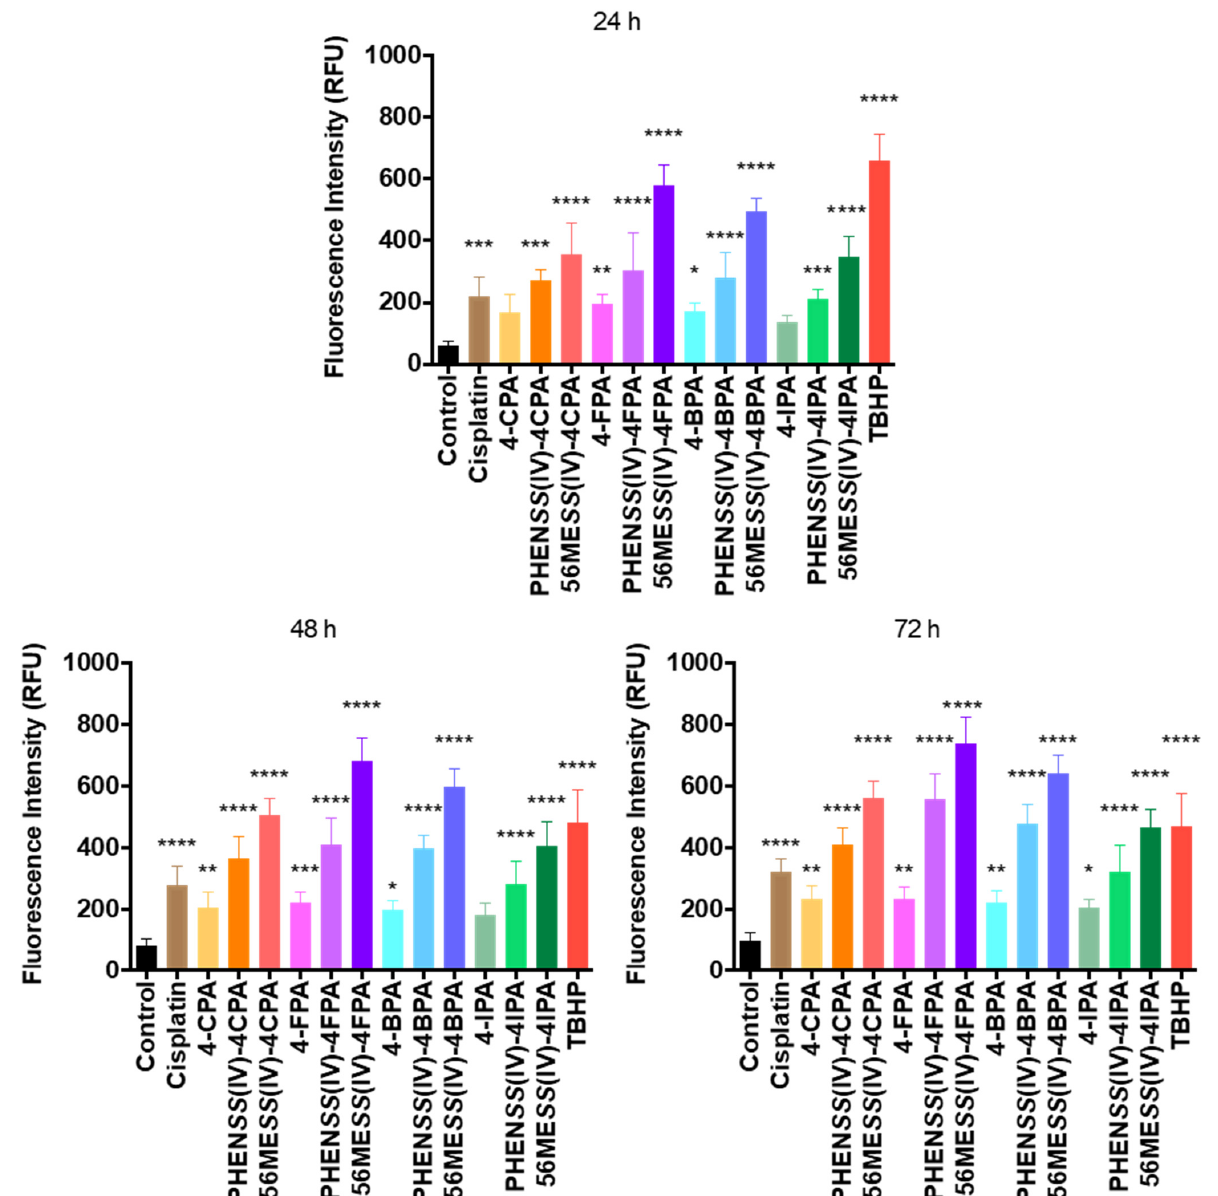
Figure 19. ROS production upon treatment with 1 – 8 , 4-CPA, 4-FPA, 4-BPA, 4-IPA, and cisplatin in HT29 colon cells at 24, 48, and 72 h. 1 = PHEN SS (IV)-4CPA ; 2 = 56ME SS (IV)-4CPA ; 3 = PHEN SS (IV)-4FPA ; 4 = 56ME SS (IV)-4FPA ; 5 = PHEN SS (IV)-4BPA ; 6 = 56ME SS (IV)-4BPA ; 7 = PHEN SS (IV)-4IPA ; 8 = 56ME SS (IV)-4IPA . **** indicates p < 0.0001 compared with the control. *** indicates p < 0.001 compared with the control. ** indicates p < 0.01, compared with the control. * indicates p < 0.05 compared with the control. Data points denote mean ± SEM. n = 3 from three independent experiments where samples were run in triplicate.